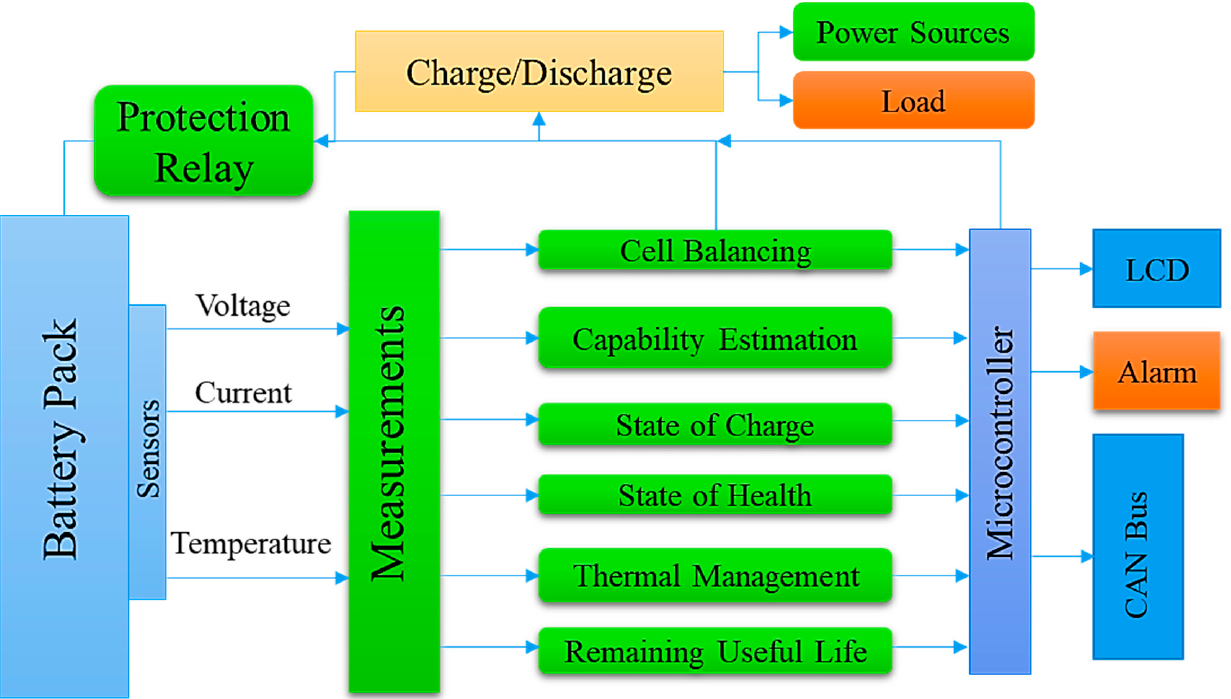
Figure 5. Battery management system, adapted from [1].